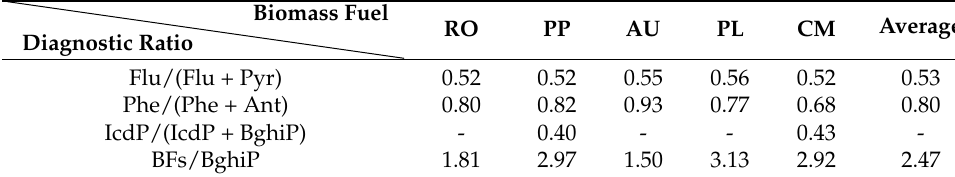
Table 5. PAHs diagnostic ratios for different biomass